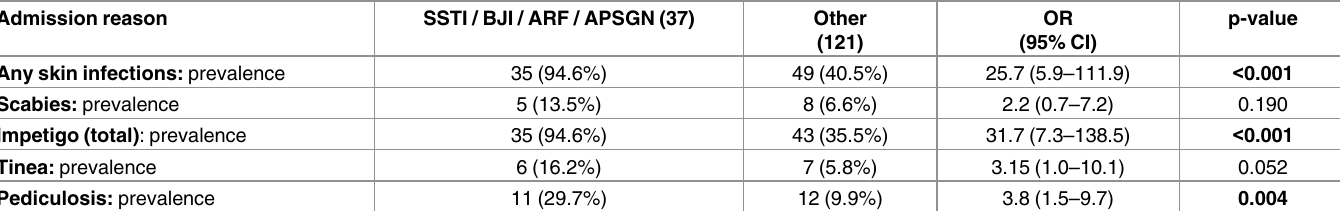
Table 6. Prevalence by admission reason (prospective).